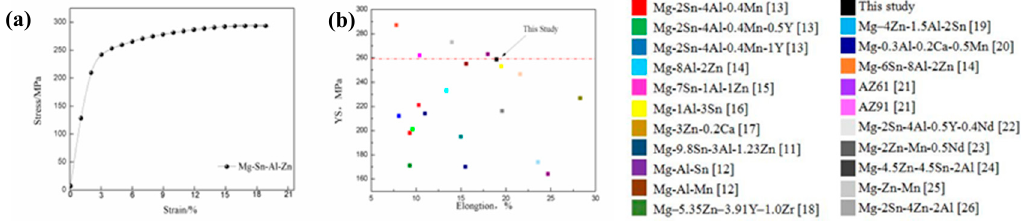
Figure 4. ( a ) Engineering stress-strain curve and ( b ) yield strength (YS) and elongation (EL) of various Mg-based extruded alloys.